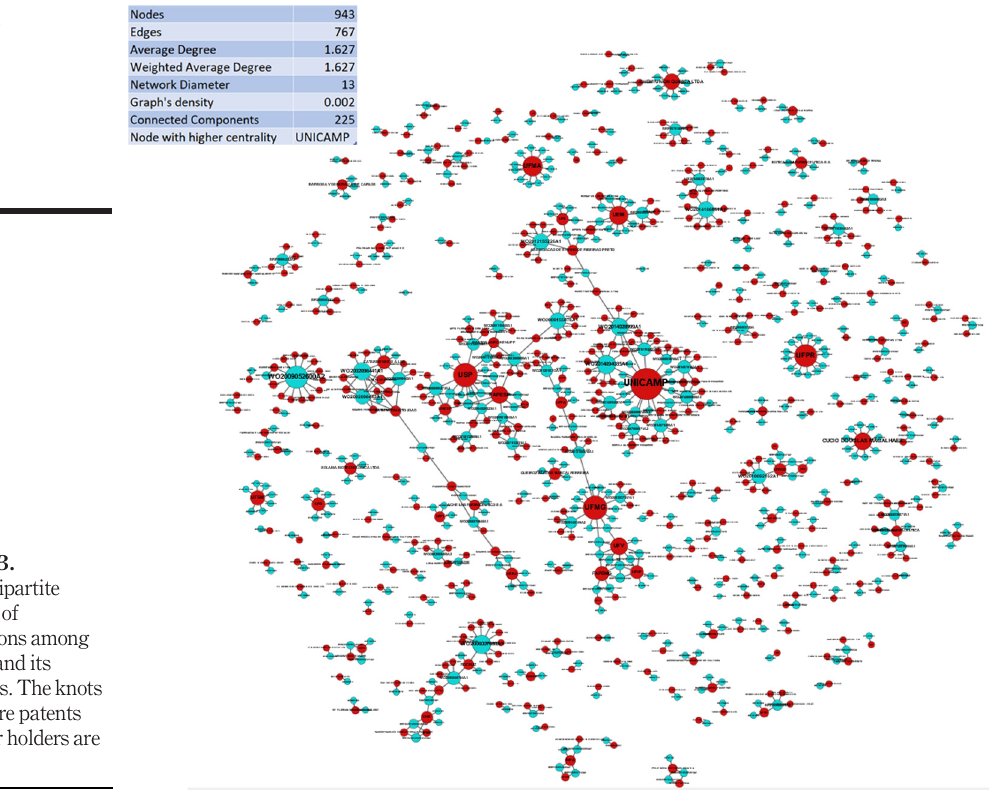
Figure 3. Global bipartite network of interactions among patents and its assignees. The